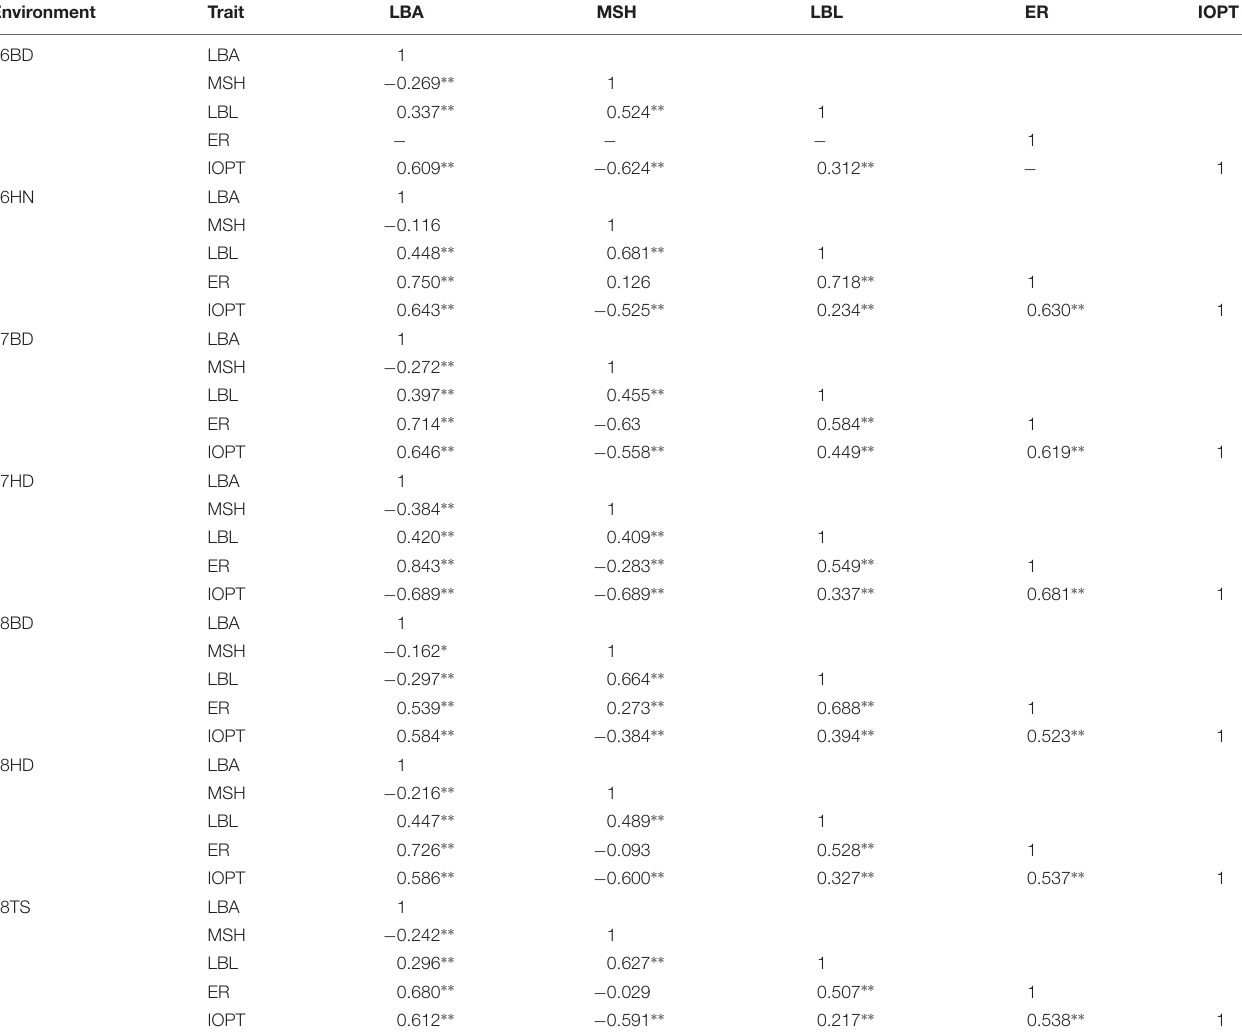
TABLE 3 | Correlation analysis of five traits in the RIL population under seven environments. Environment